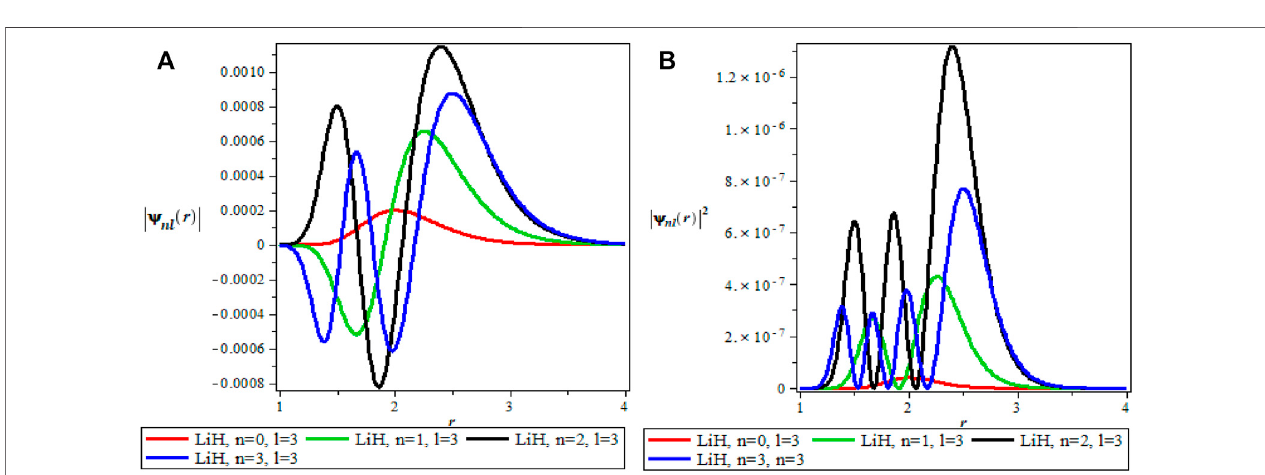
FIGURE 4 | (A) Wavefunction plot for fi xed l = 3 for LiH molecule. (B) Probabilty density plot for fi xed l = 3 for LiH molecule.